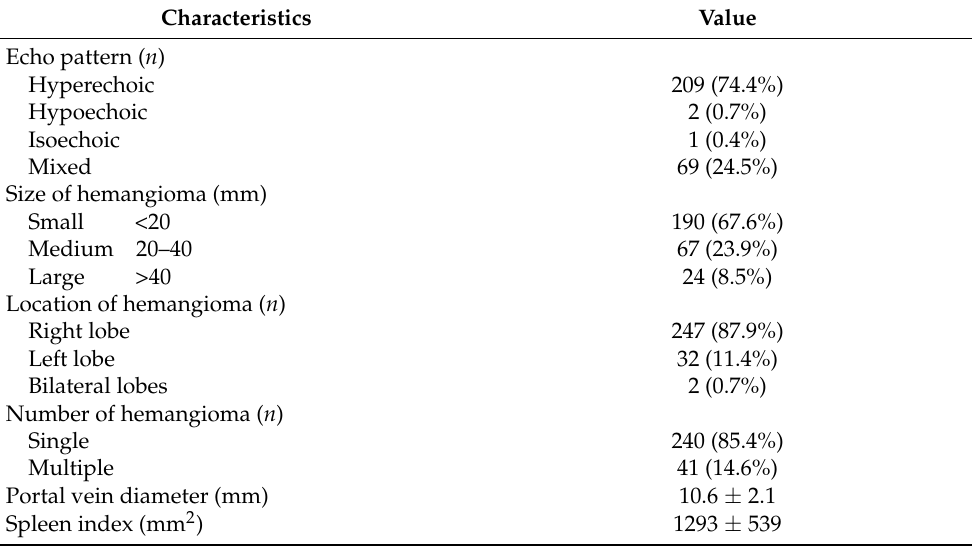
Table 2. Ultrasonography findings of 281 patients with hepatic hemangiomas.